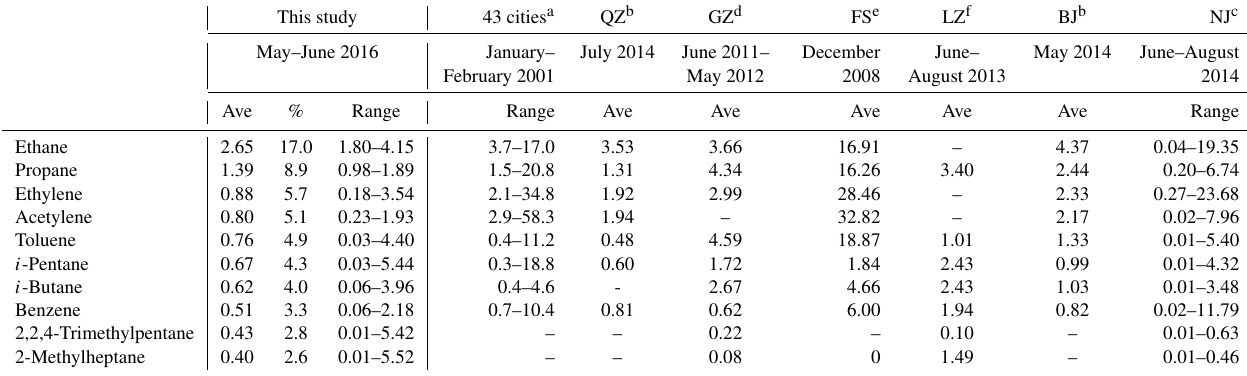
Table 4. Comparison of the top 10 most abundant species measured in this study with other ground observations in China (units: ppbv). This study